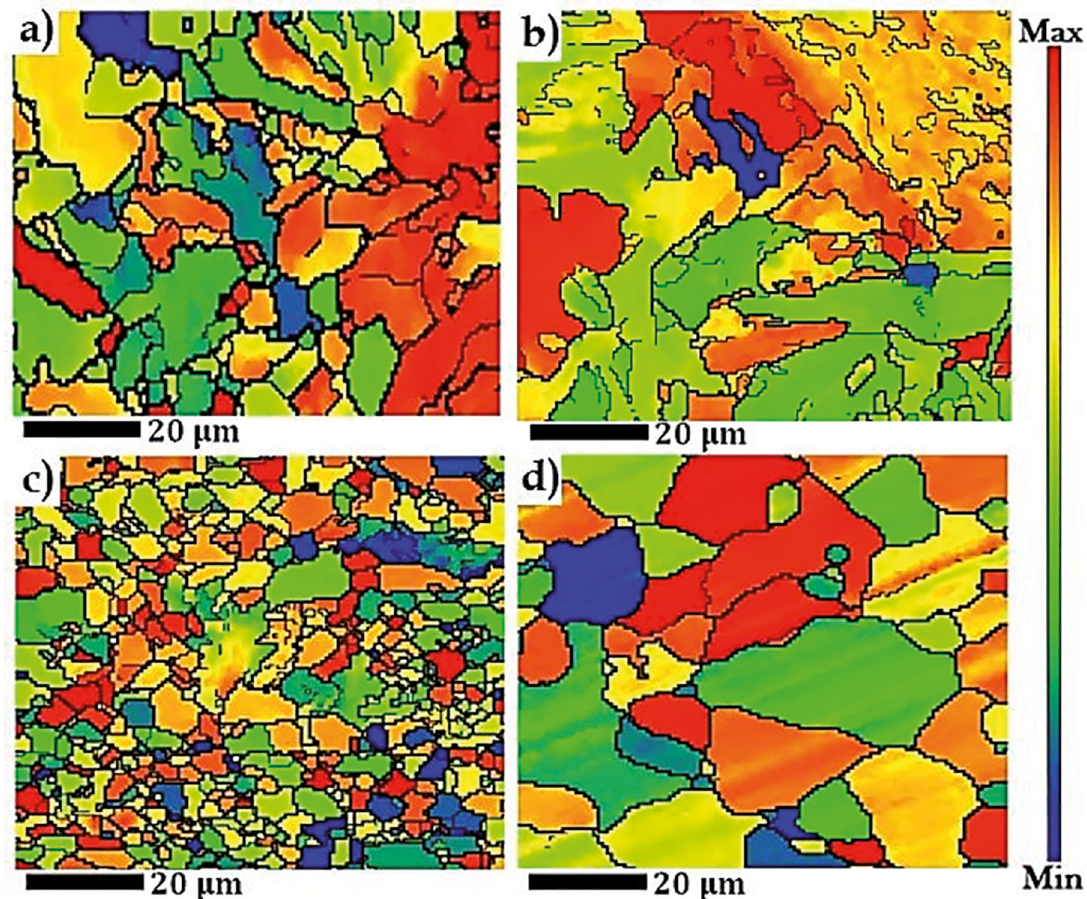
Figure 8: Taylor Factor maps of (a) AC, (b) ACN, (c) WQ350 and (d) WQ700 samples.